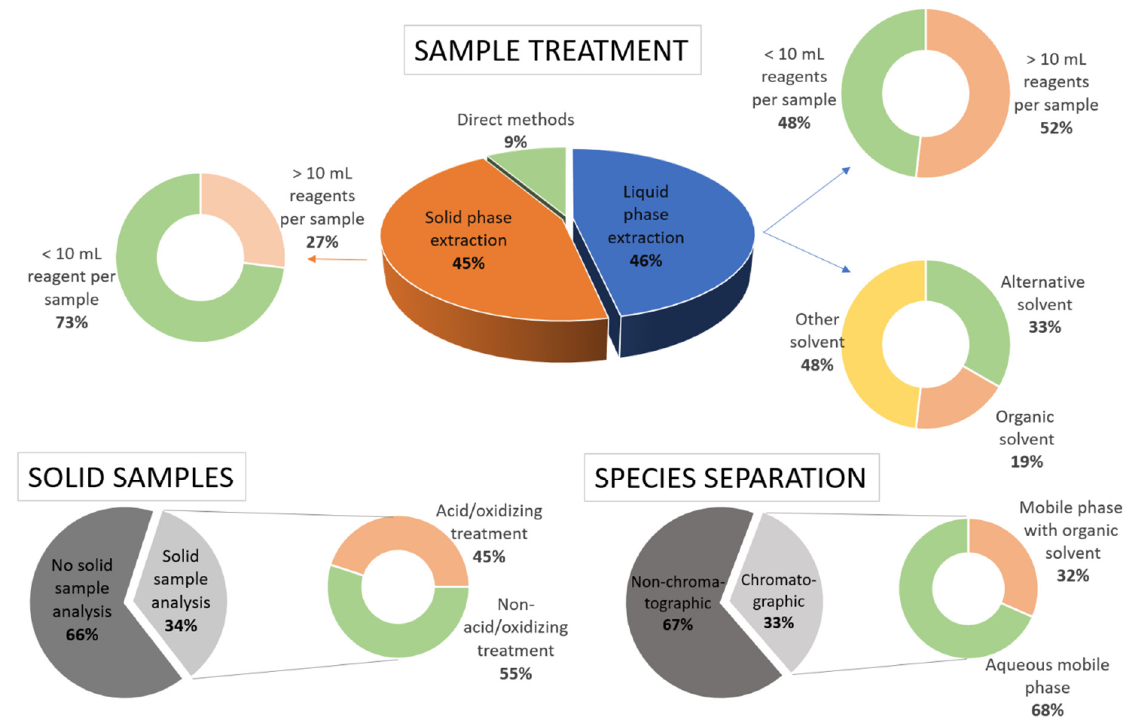
Figure 3. Distribution of diverse factors affecting the environmental impact of the reports included in this article.